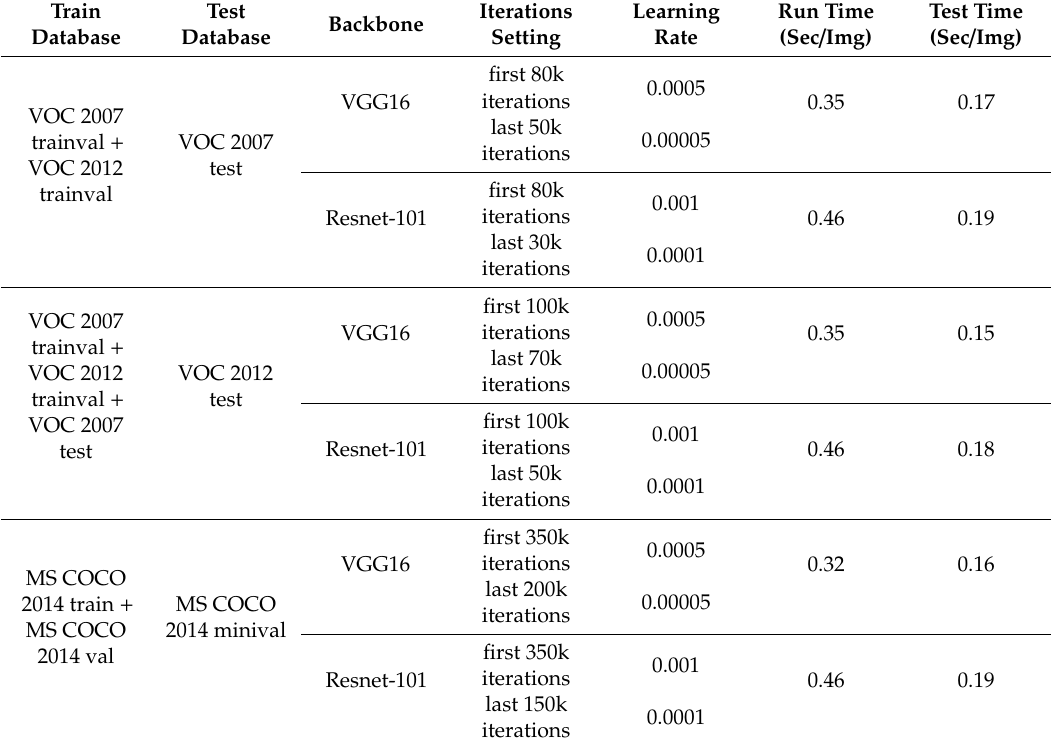
Table 1. Experimental parameter